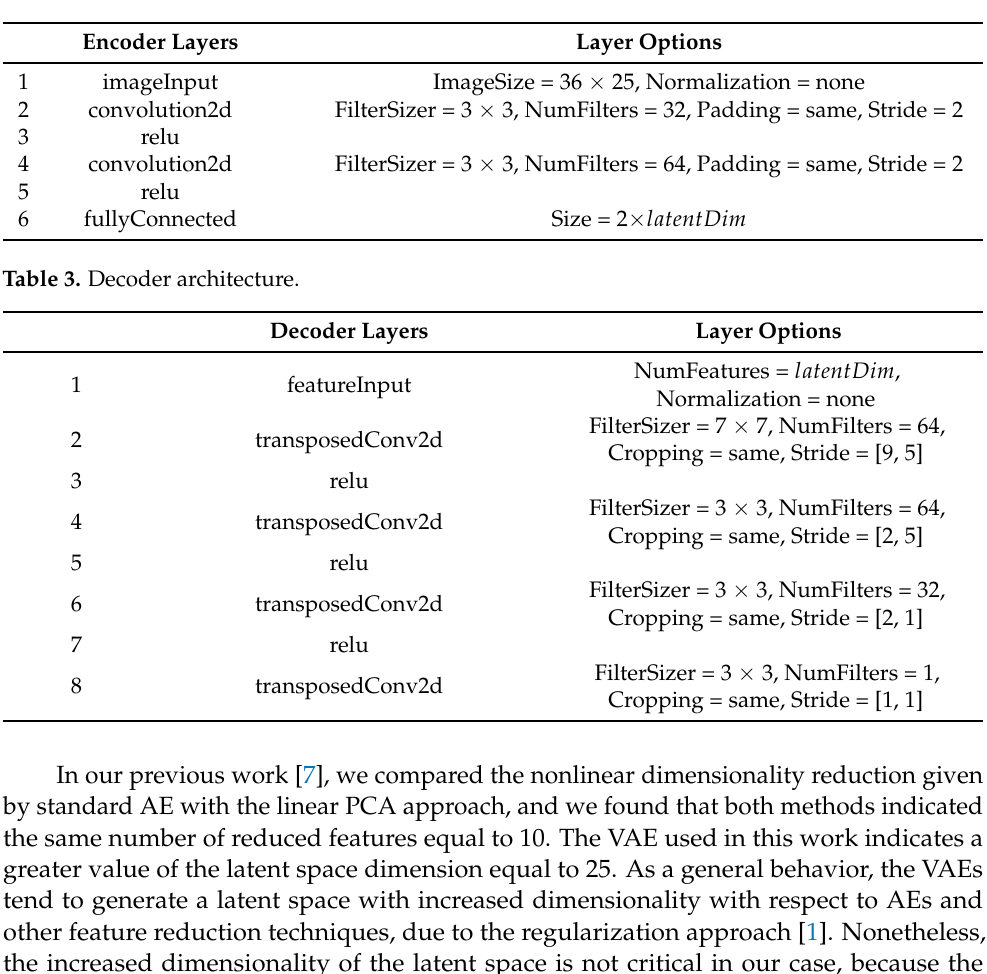
Table 2. Encoder architecture.